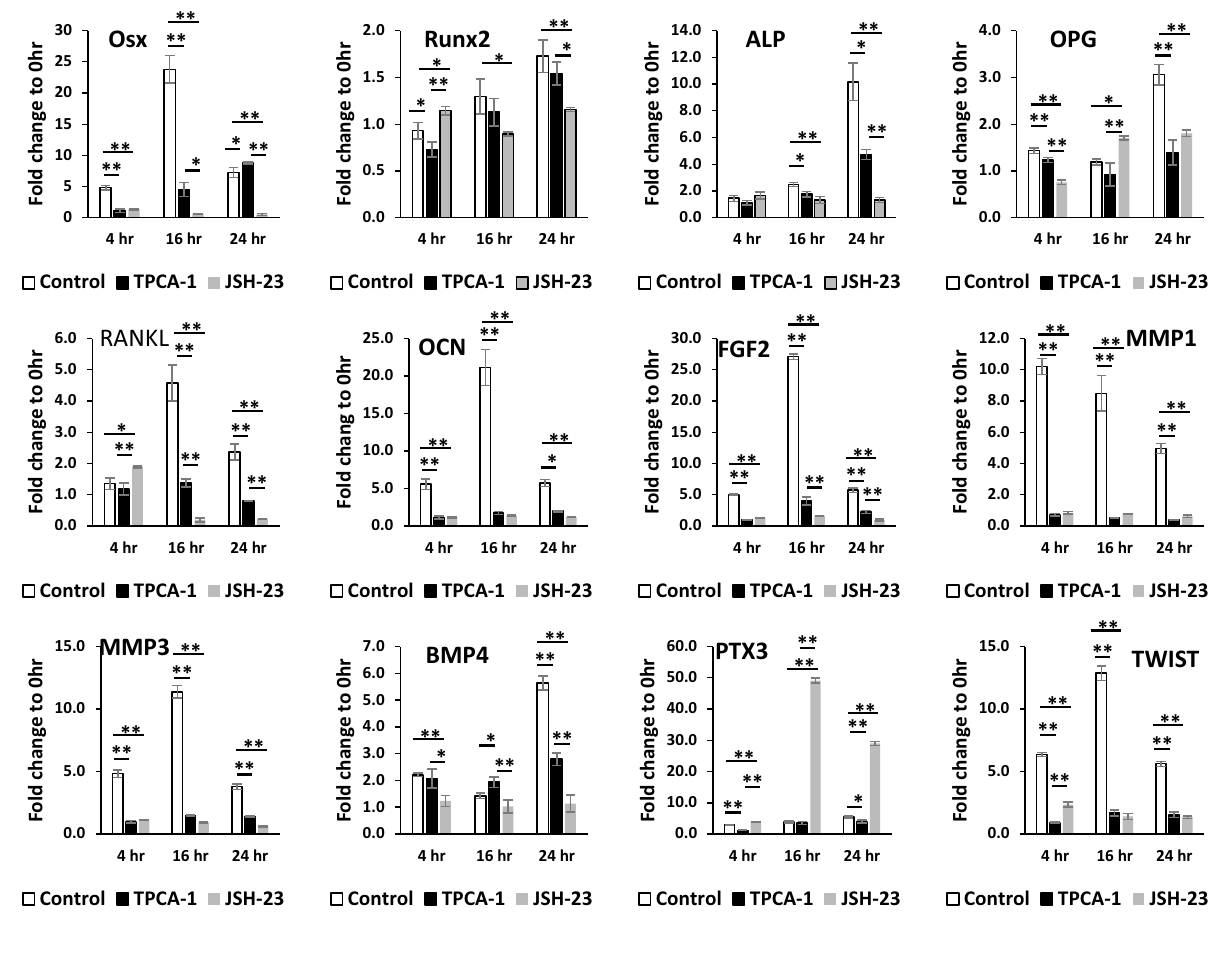
Figure 4. Effect of DPP-mediated NF-κB activation on the odontogenic differentiation of DPSCs. DPSCs were cultured under growth conditions and were treated with (open bars) or without TPCA-1 (closed bars) or JSH-23 for 60 min and stimulated with 500 ng DPP and cultured under growth conditions for 0–96 h. Total RNA was isolated and quantitative RT-PCR analysis performed. Fold changes were obtained relative to 0 h. Expression levels of early odontogenic markers such as; Osx, Runx2, Alp, OPG, RANKL, OCN, FGF2, MMP1, MMP3, BMP4, PTX3 and TWIST increased with DPP-mediated NF-κB signaling. Specificity of NF-κB signaling was determined by gene expression analysis in the presence of NF-κB signaling pathway inhibitors, TPCA-1 and JSH-23. Data are means ± SD of triplicates. Means and SDs of fold changes to 0 h are shown. Significant difference *p < 0.05; **p <